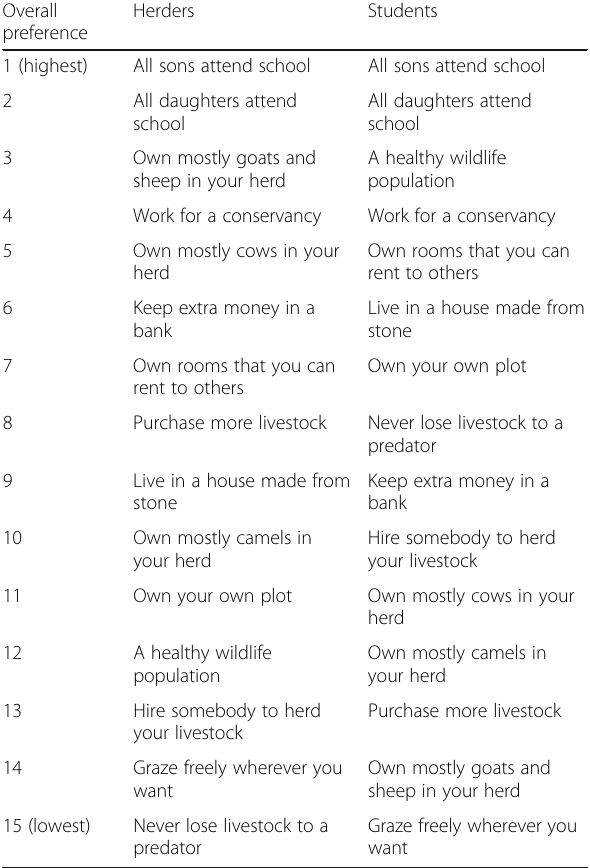
Table 2 Ranked options for herders and school-enrolled youth in order of preference Overall